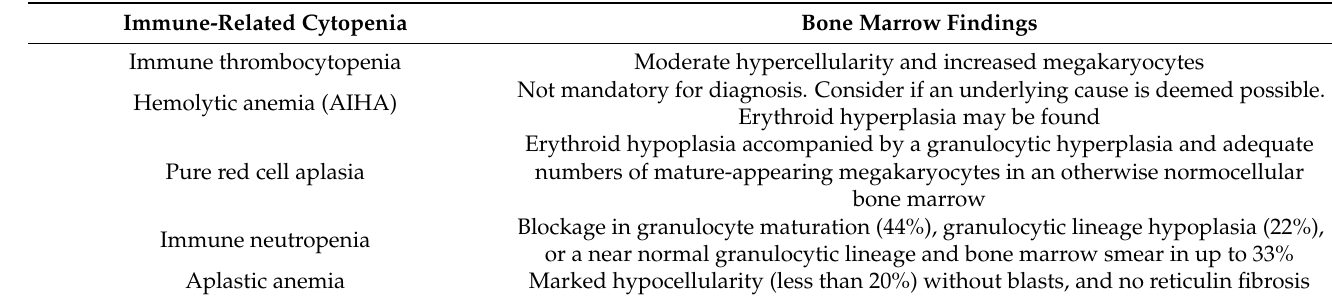
Table 3. Bone marrow findings in ICI-related cytopenias [59,65,66,75,76,83]. Immune-Related Cytopenia Bone Marrow